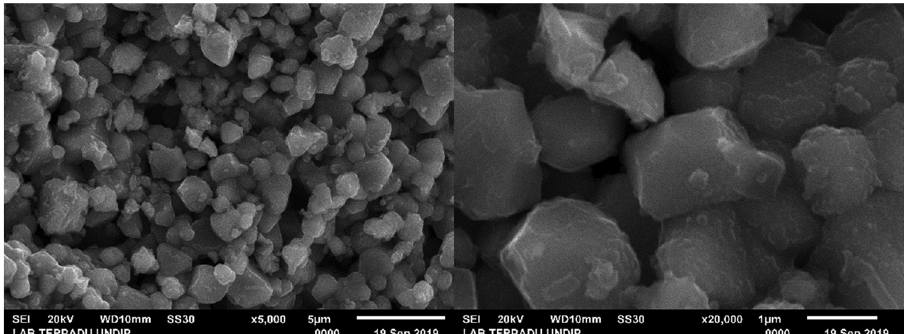
Figure 4: SEM images of NCA powder.